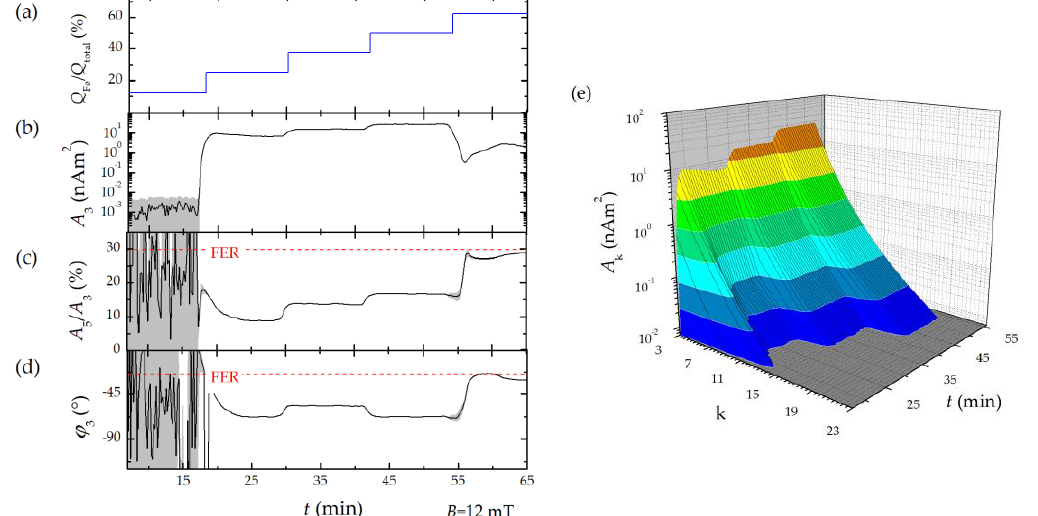
Figure 6. Inline benchtop MPS monitoring of micromixer MNP synthesis. ( a ) Time-dependent changing of iron to OH flow rate ratio. ( b ) Mean of MPS signal parameters A 3 , ( c ) A 5 / A 3 , ( d ) ϕ 3 (black lines) and standard deviation (grey shaded area) of 10 consecutive measurements. The dotted red line highlights the values of FER. ( e ) Surface plot of time dependent MPS spectra.